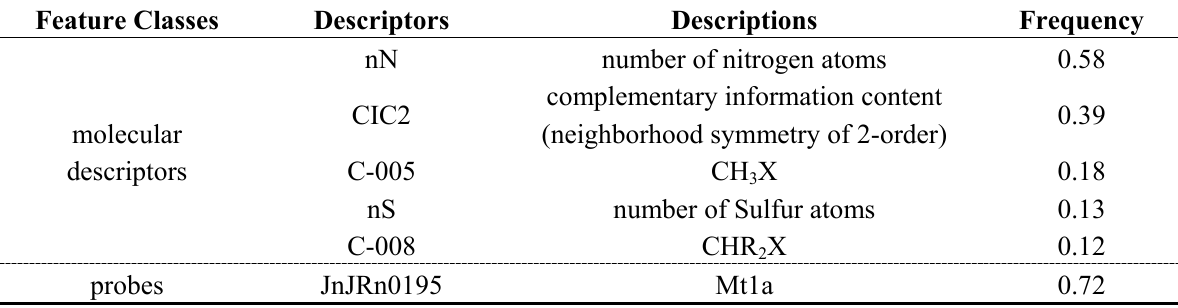
Table 1. Selected molecular descriptors and gene expression